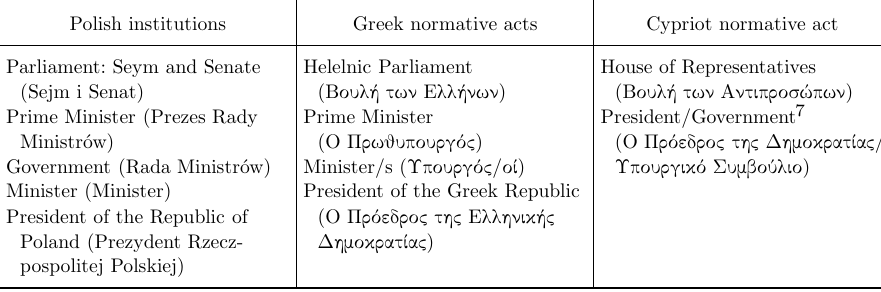
Table 4 Institutions enacting and promulgating normative acts Polish